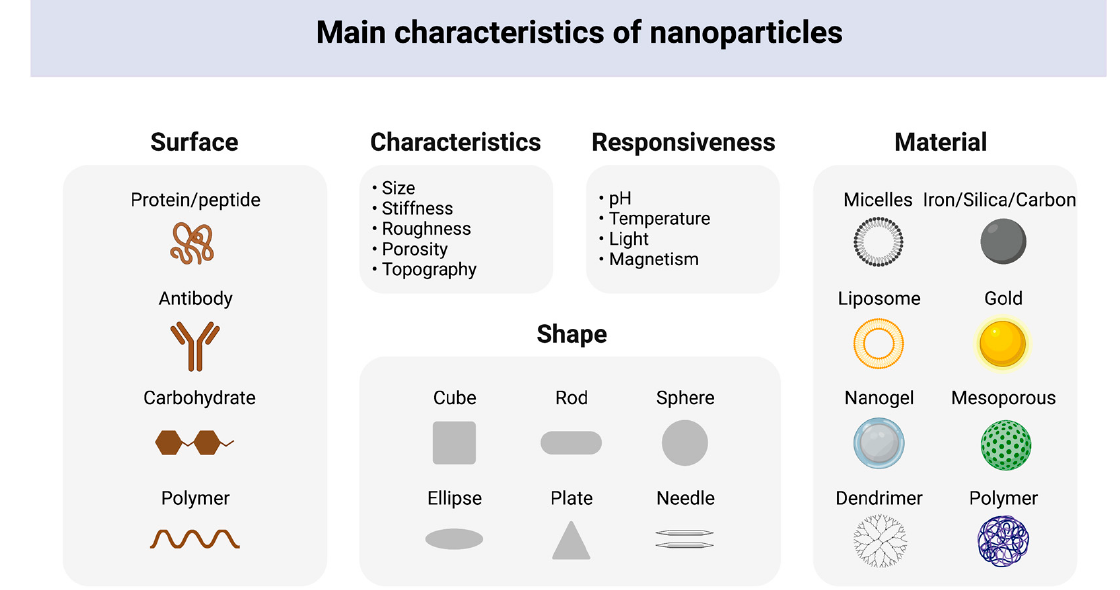
Figure 4. Physical and chemical properties of NPs, including the surface, shapes, characteristics, responsiveness, and nano-based materials. Created with BioRender.com.